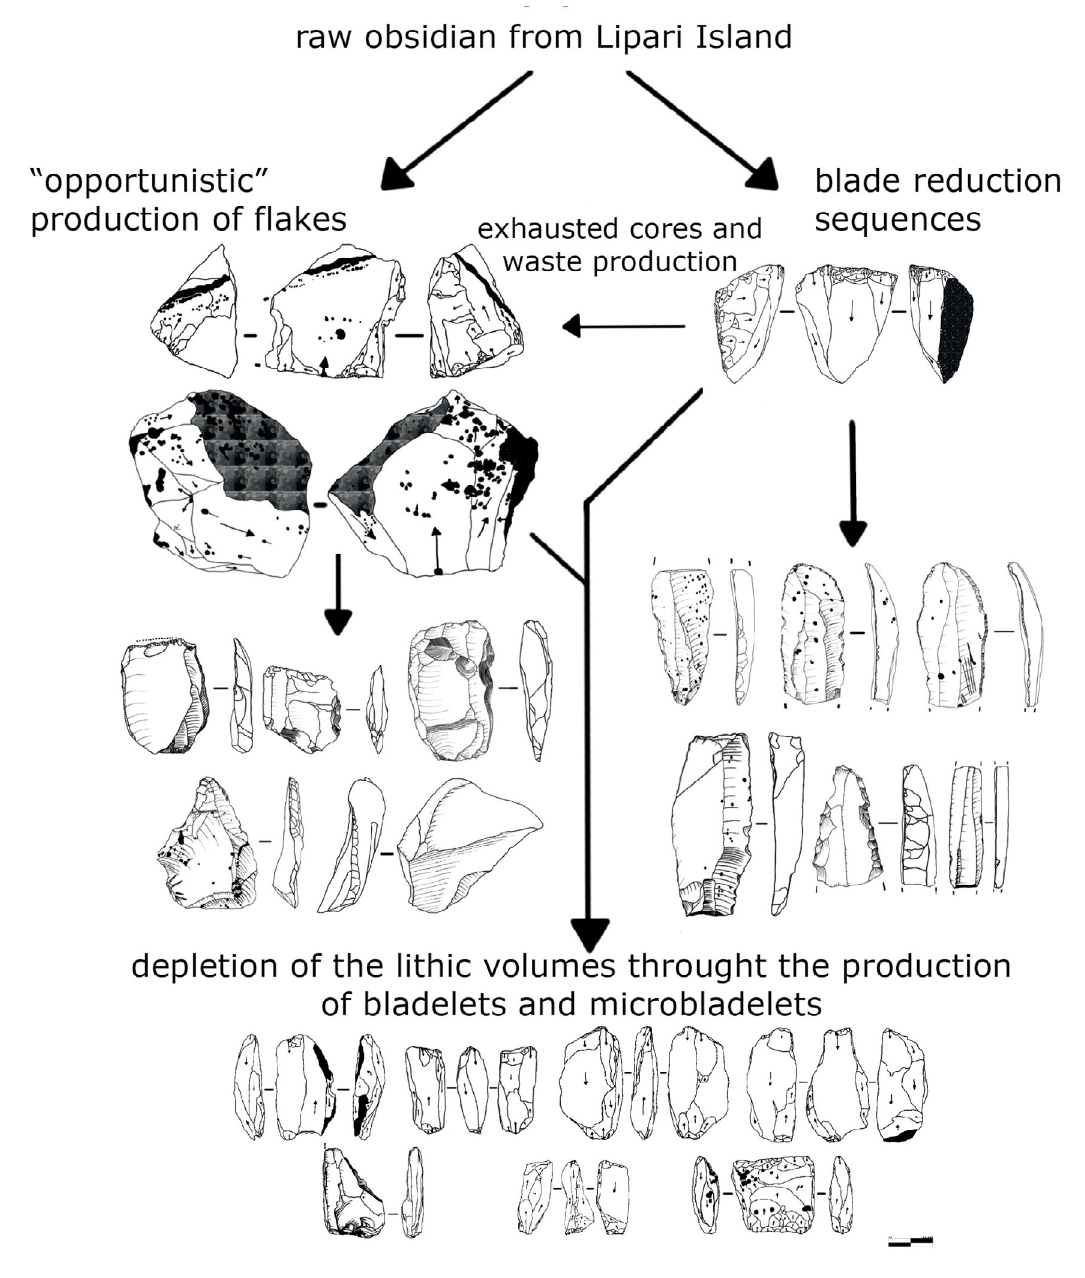
Figure 6. Chaine operatoire at San Vincenzo (D.